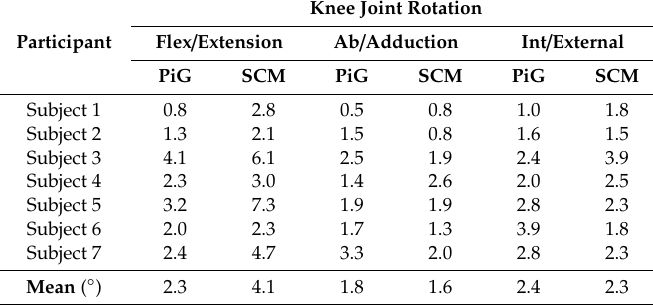
Table 4. Within-subject variability of knee joint rotation over the sound gait cycle across three trials per participant as calculated by PiG and SCM is shown by the standard deviation,